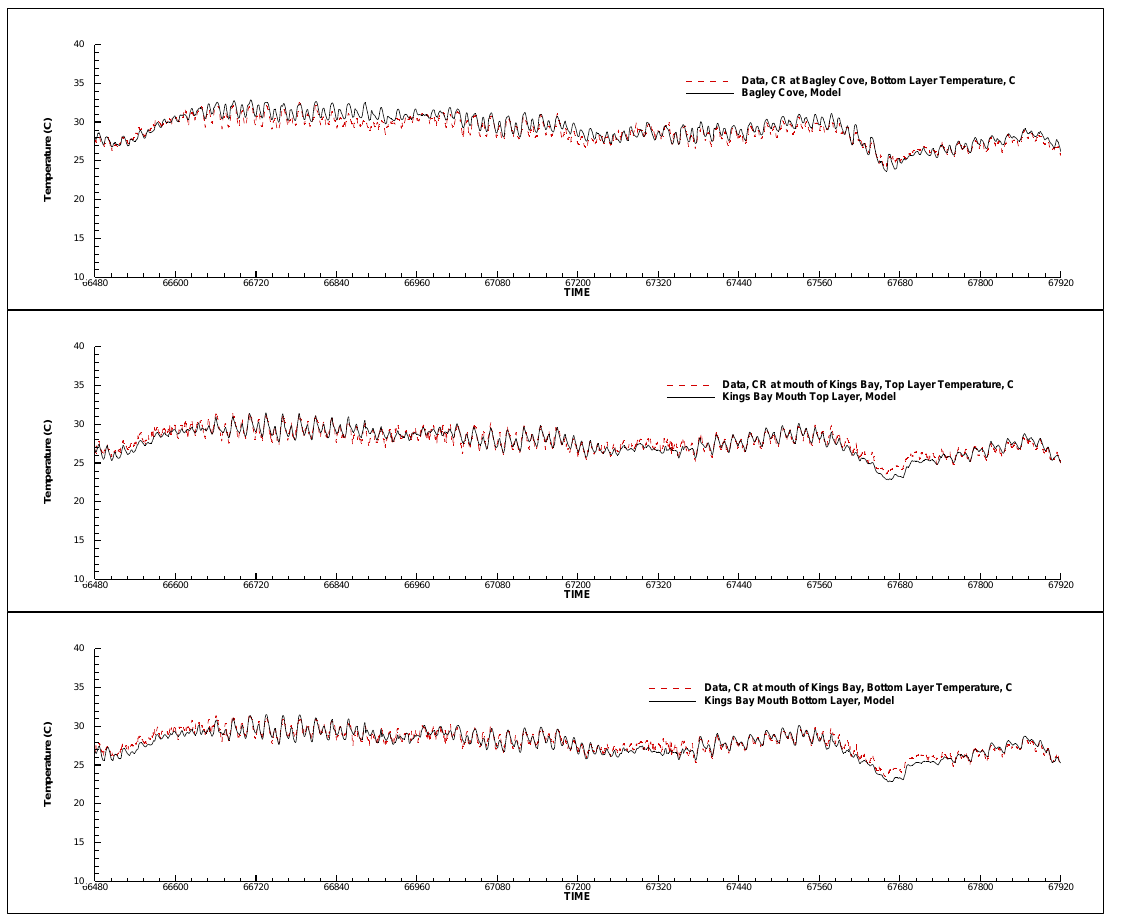
Figure 9. Comparison of measured and simulated temperatures near the bottom at the Bagley Cove station (top panel), in the top layer at the mouth of King Bay station (middle panel), and in the bottom layer at the mouth of Kings Bay station (bottom panel) during 2 August–1 October